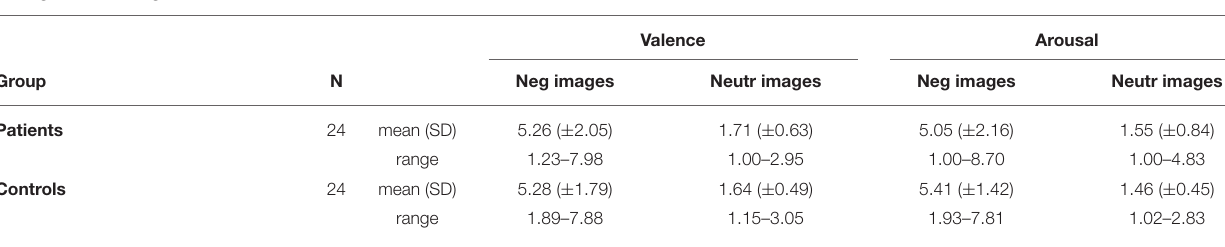
TABLE 2 | Rating of IAPS images. Rating of IAPS images: mean